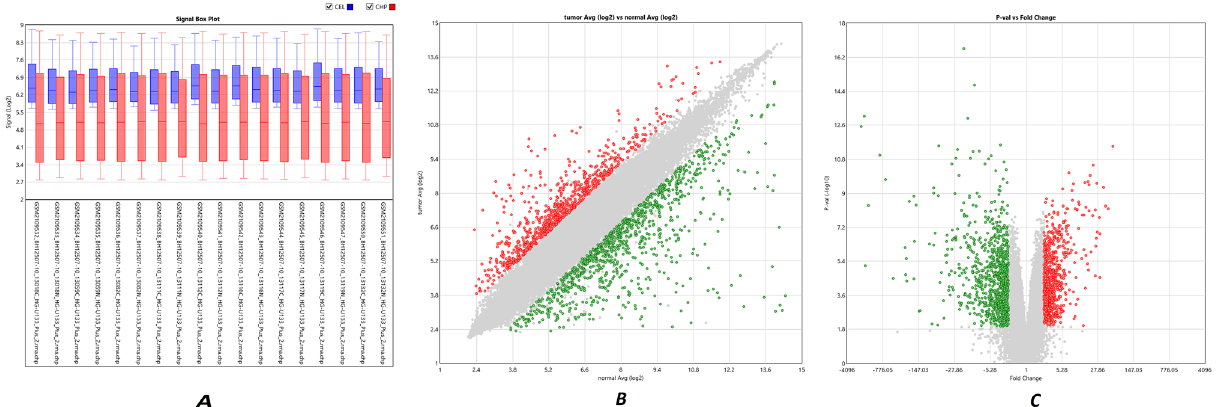
Figure 2. Normalization and gene filtering of the microarray data. ( A ) Box plot gene expression distribution in each patient and data normalization of microarray samples. For each microarray sample, blue box plot (CEL) shows microarray gene expression distribution before normalization, and red box plot (CHP) represents gene expression distibution after normalization. ( B ) The scatter plot of DEGs (differentially expressed genes). It shows varience of the average gene expression in normal versus tumor patients. ( C ) Volcano plot of DEGs (differentially expressed genes) between gastric adenocarcinoma samples versus paired normal tissue. It shows signficant gene expression based on ther p -value and fold change. Note: In ( B ) and ( C ), red and green dots show upregulated and downregulated genes, respectively. Besides, gray nodes are the DEGS whose fold change is below the determined limit in the study.